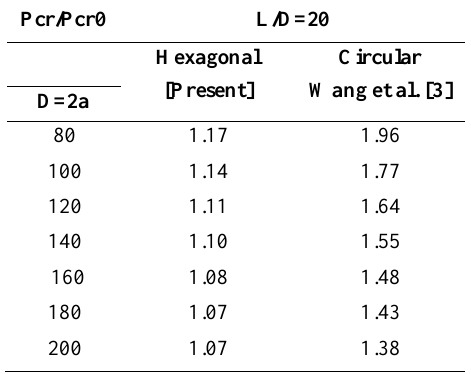
Table 1 . Normalized amplitude versus V/V